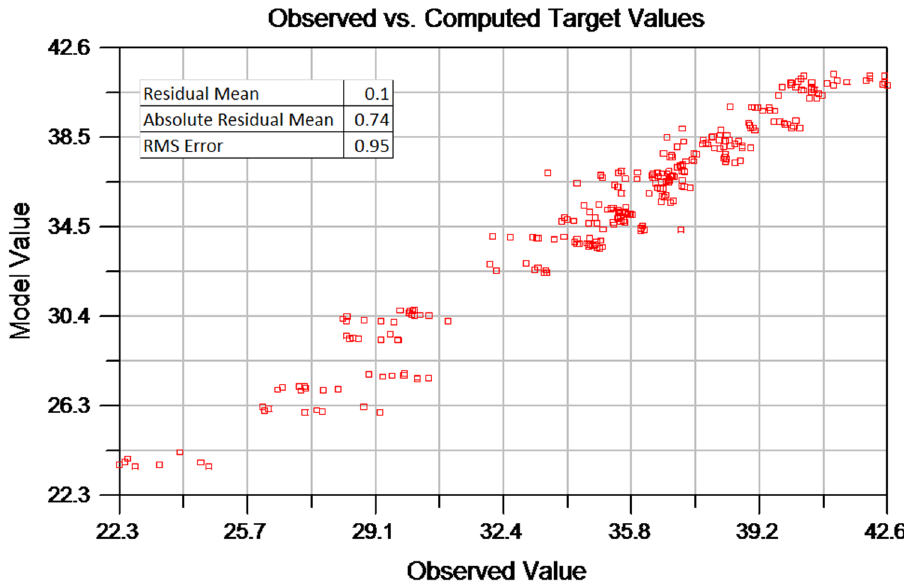
Figure 7. Heads (in meters) obtained at the end of the model calibration period (April 2014) compared with observed heads measured at over 35 wells across the model domain.